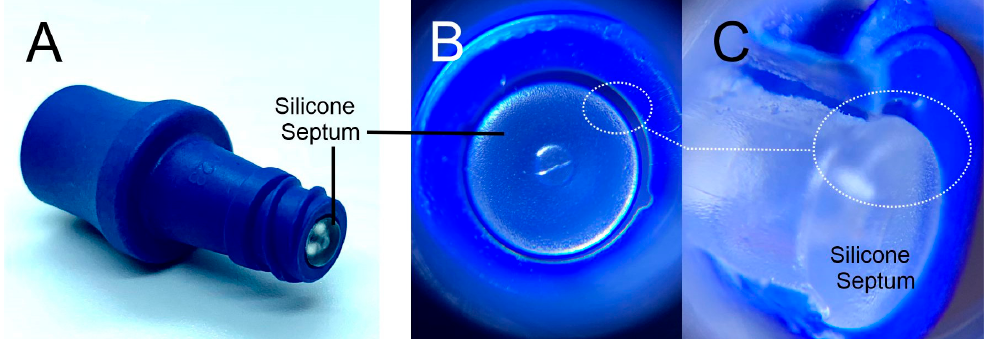
Figure 3. ICU Medical Clave™ needle free connector ( A ). Optical image of the septum ( B ) and cut through section ( C ) highlighting gaps in the structure.